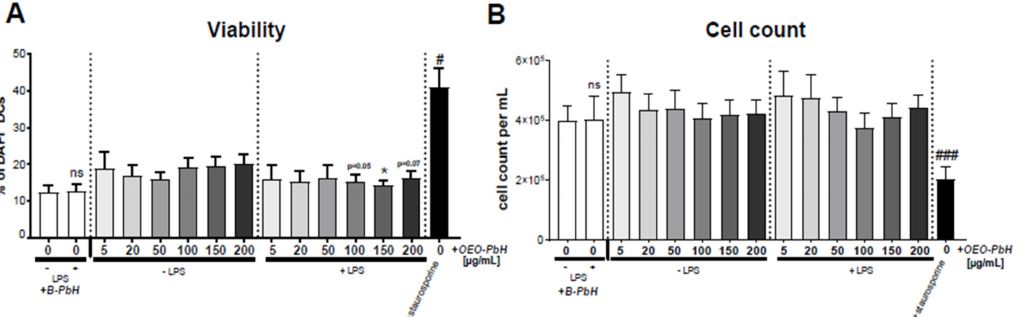
Figure 9. Effects of OEO-PbH on the viability of human DCs. DCs were cultured for 7 days with GM-CSF and IL-4. Cells were subsequently stimulated without LPS or with LPS and treated with the OEO-PbH at different concentrations for 24 h. Viability ( A ) as well as the absolute number of DCs ( B ) were assessed using flow cytometry. Staurosporine-treated DCs served as a positive control (black bar). ( A ) Frequency of DAPI + (dead cells). ( B ) Absolute cell number in cell culture 24 h after stimulation calculated as cells/mL. Data expressed as mean ± SEM ( n = 6 donors); # indicates comparisons to the respective blank control (B-PbH-treated DCs) using RM one-way ANOVA; * indicates group comparisons between LPS-treated and LPS-untreated cells using paired t -test (# p < 0.05; ### p < 0.001; ns = not